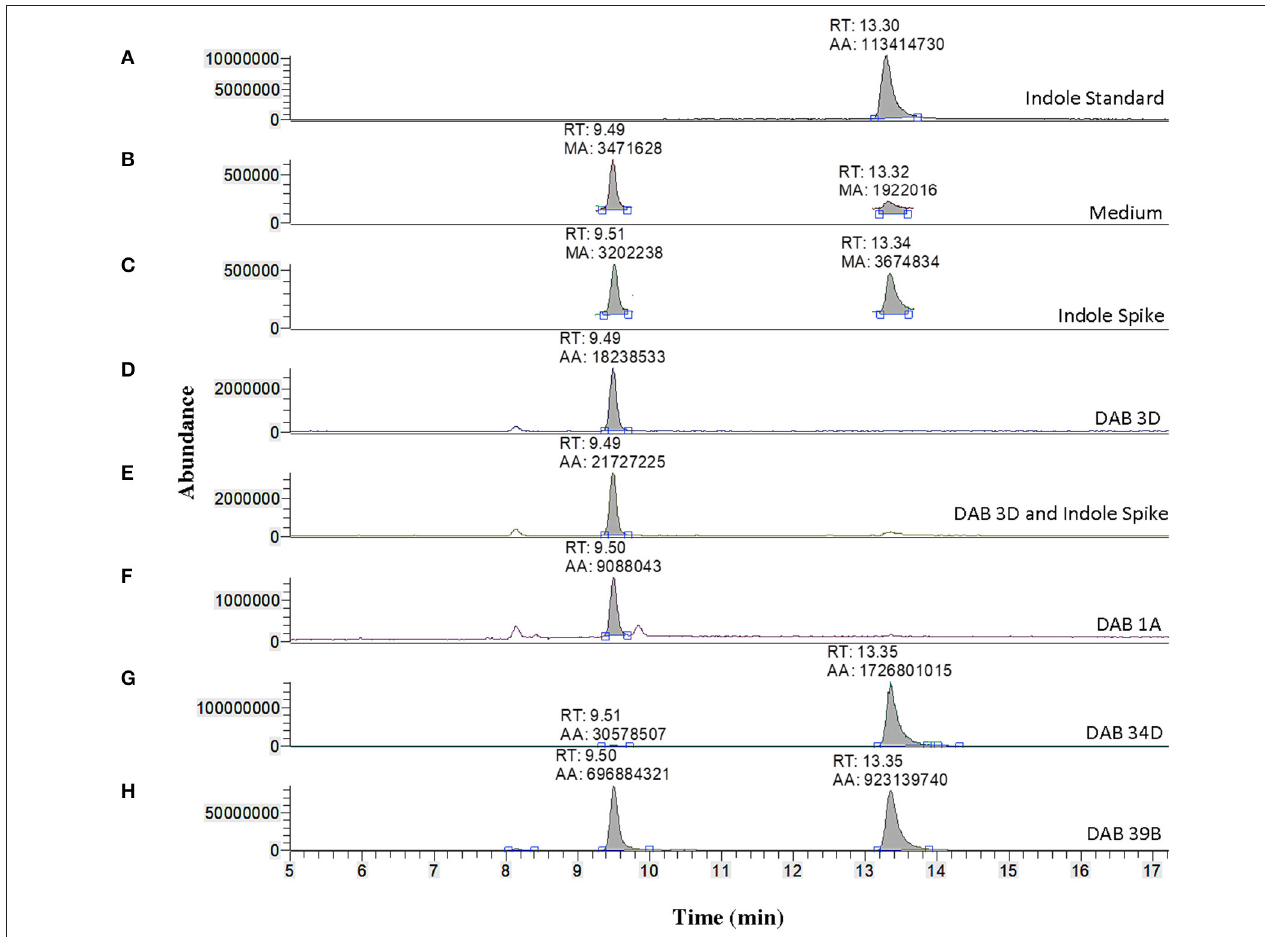
FIGURE 6 | Identification of indole production in brown-type DABs by mass spectrometry. LC-MS extracted positive ionization ion chromatograms at m/z 118.06 to m/z 118.07 ([M + H] of indole). RT, retention time; AA, automatic area under peak; MA, manual area under peak. (A) EIC from an injection of 100 ng/ µ L free indole in 100% acetonitrile showing a retention time of 13.30min. (B) EIC showing a low background signal at the RT of free indole in the LB medium sample. A second signal is detected at a retention time of 9.49min in the LB medium. (C) EIC showing free indole in the LB medium spiked with 100 ng/ µ L of free indole. (D) EIC from the LB medium with non-color Bacillus strain, DAB 3D. (E) EIC from the LB medium with DAB 3D spiked with 100 ng/ µ L free indole. The indole peak area is < LoQ at the scale of the chromatogram. (F) EIC from the LB medium with pink-type Microbacterium strain DAB 1A, showing no detectable indole. (G) EIC from the LB medium with brown-type Vogesella strain DAB 34D, showing a clear indole signal. (H) EIC from the LB medium with brown-type Aeromonas strain DAB 39B, showing a clear indole signal. The scales on the Y-axis are automatically adjusted to show all the peaks in each of the chromatograms. Note the different scale on the chromatogram in (B,C) to show the lower quantity